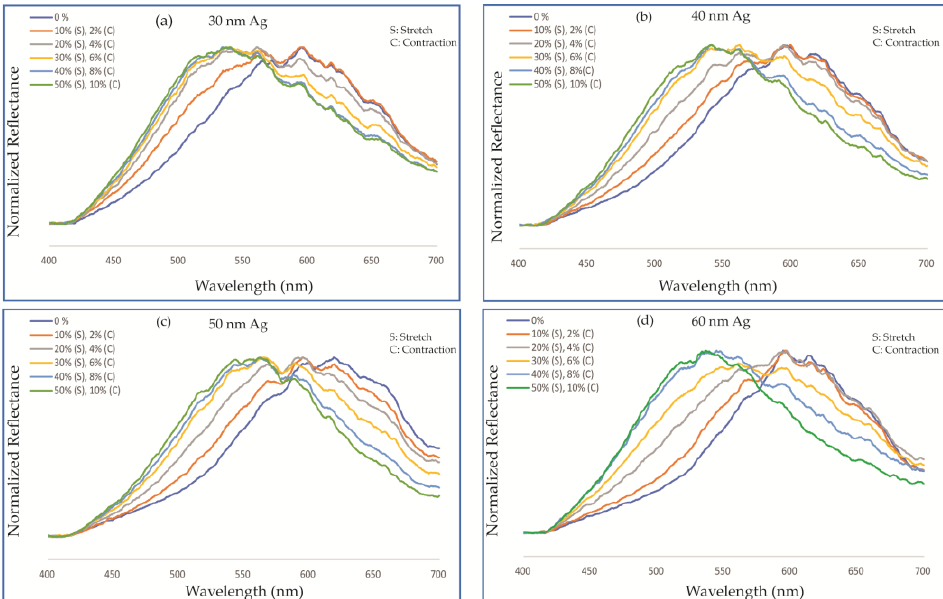
Figure 8. Normalized reflectance graph measured by a spectrometer for different thicknesses of deposited Ag: ( a ) 30 nm, ( b ) 40 nm, ( c ) 50 nm, and ( d ) 60 nm. The PDMS membrane underwent a strain from 0 to 50% in the direction being stretched and, as a result, a contraction from 0 to 10% in the other lateral direction.